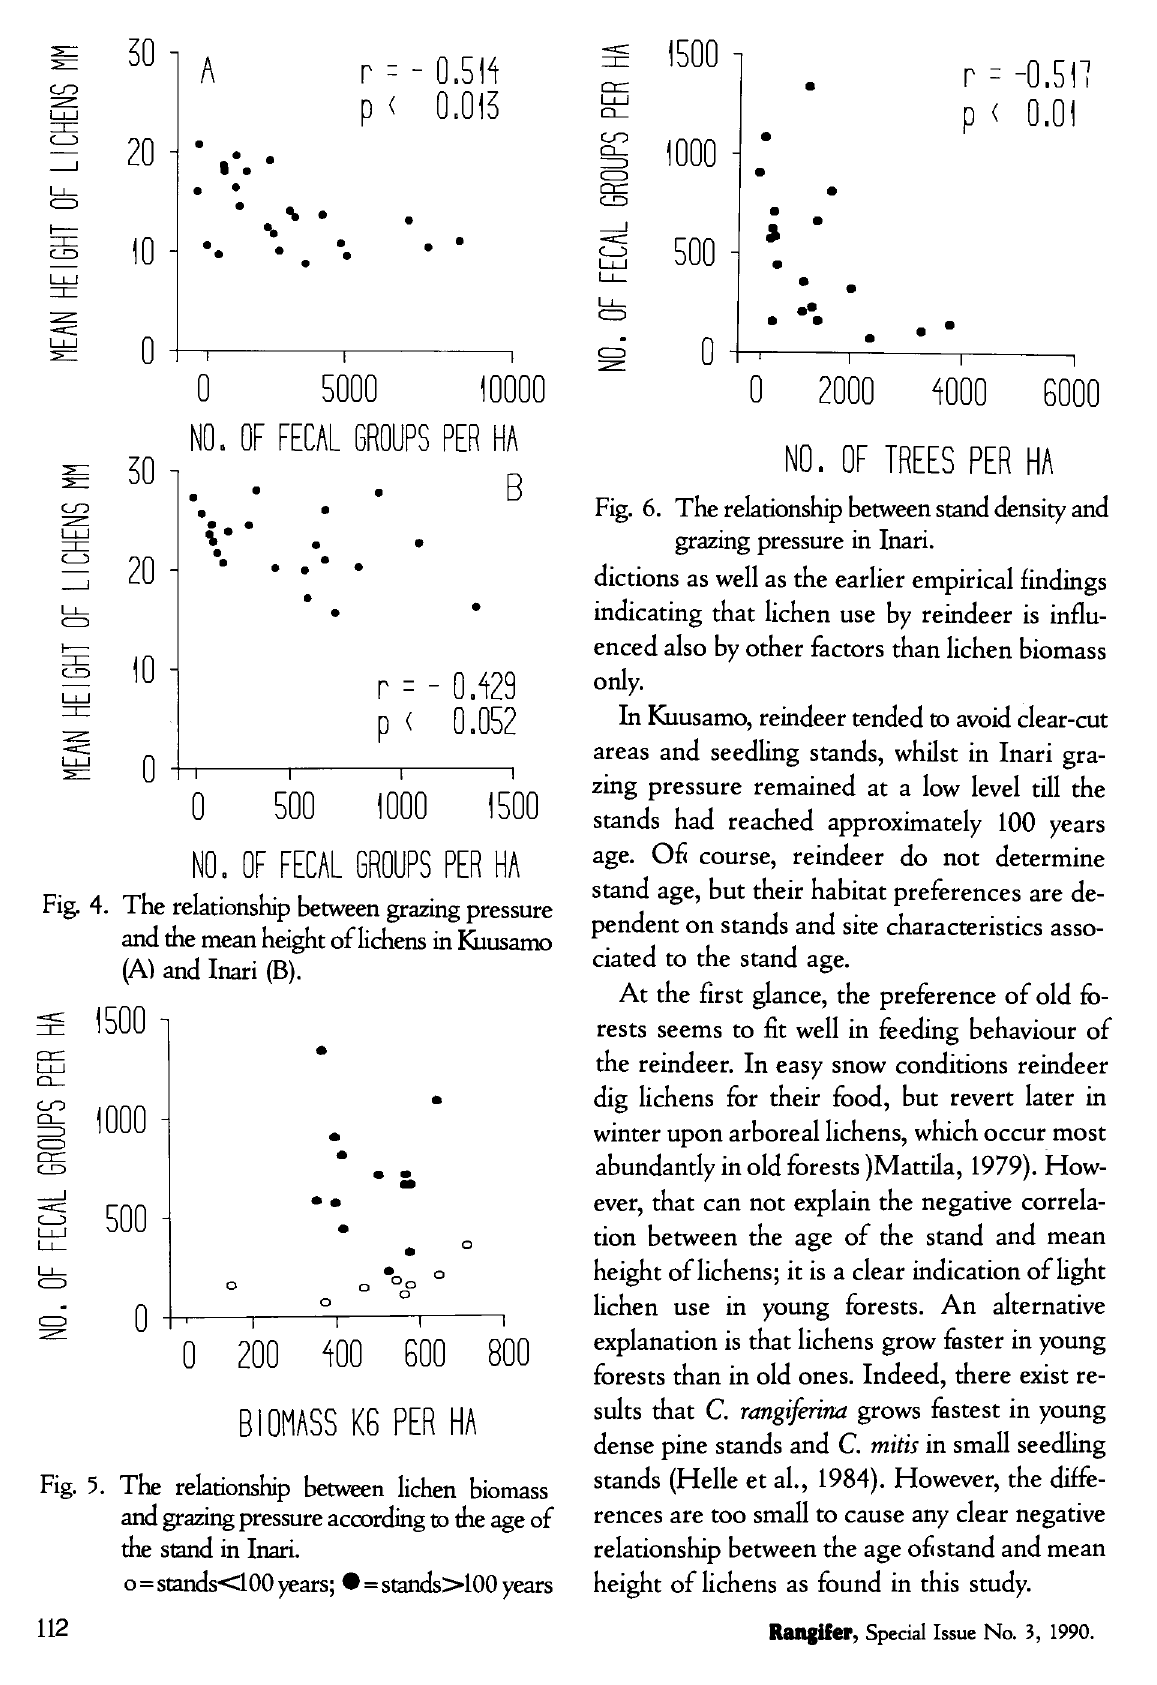
Fig. 6. The relationship between stand density